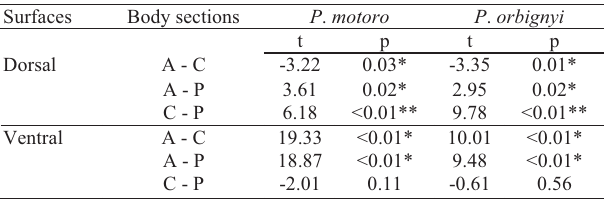
Lateral line canals on the dorsal body surface. The distributions of lateral line canals on the dorsal surface of Potamotrygon motoro , P . orbignyi and Potamotrygon sp. branches of the hyomandibular canal. No significant